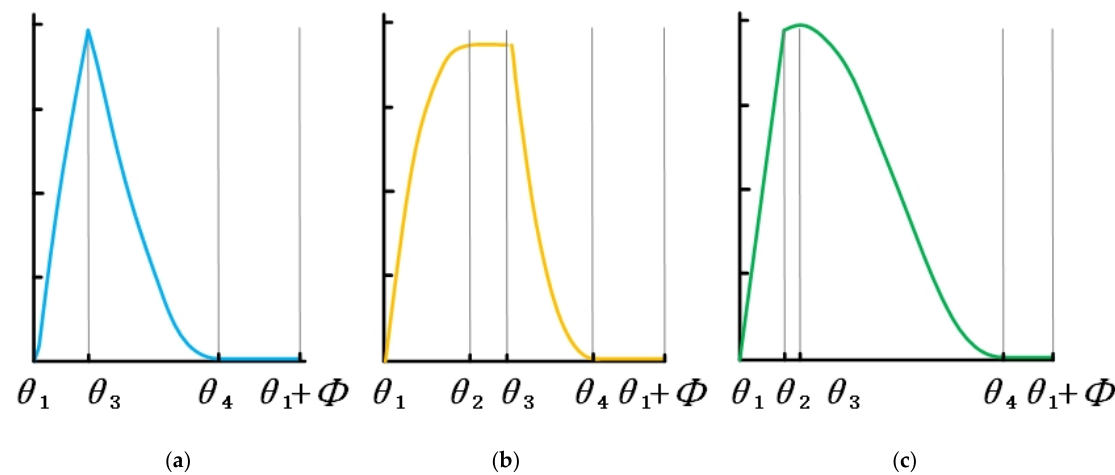
Figure 4. The waveform of the force signal for a single flute in a period. ( a ) Type I, ( b ) Type II and ( c ) Type III [40].